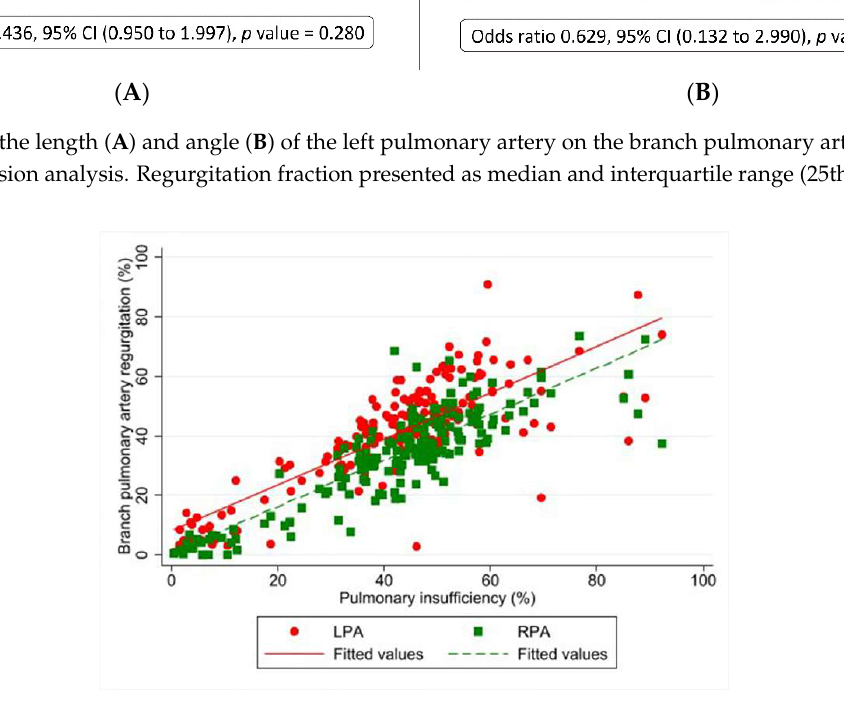
Figure 4. Effect of the length ( A ) and angle ( B ) of the left pulmonary artery on the branch pulmonary artery regurgitation, using linear regression analysis. Regurgitation fraction presented as median and interquartile range (25th–75th percentile).